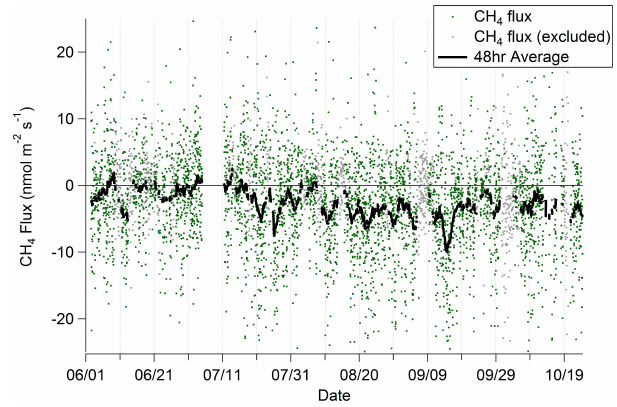
Fig. 3. CH 4 flux (green) with excluded data (gray) and limit of de- tection of individual flux measurements (dashed red) and distribu- tion (right panel) from 2 June to 24 October